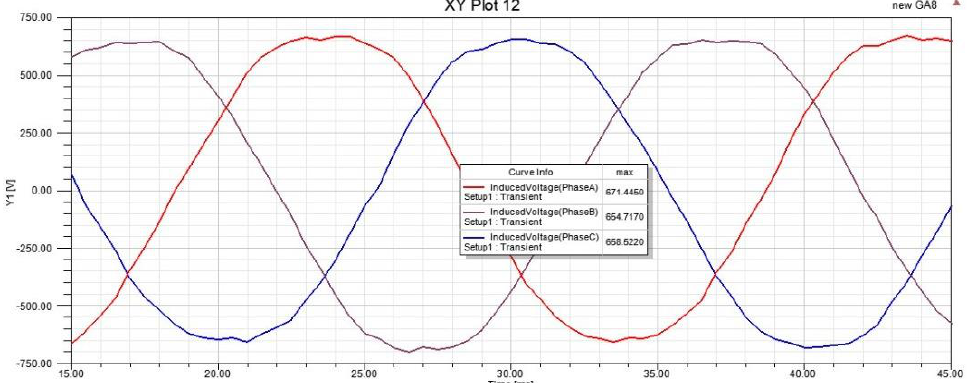
Figure 8. Three-phase back-EMF at 250 rpm.